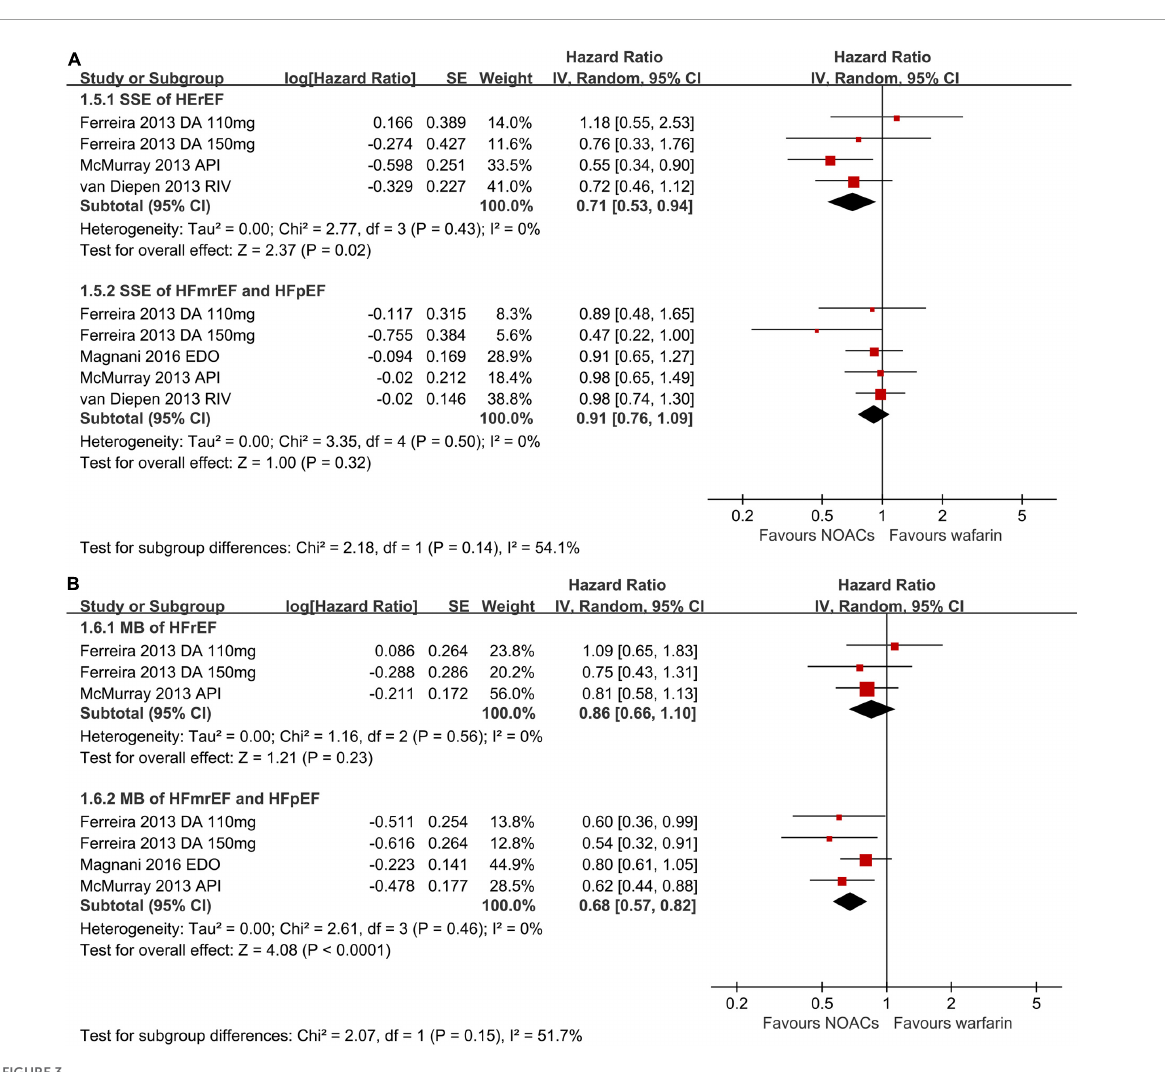
FIGURE3 Forest plot for primary effectiveness (A) and safety (B) outcomes in HFrEF, HFmrEF, and HFpEF. HFrEF, heart failure with reduced ejection fraction; HFmrEF, heart failure with mildly reduced ejection fraction; HFpEF, heart failure with preserved ejection fraction; CI, confidence